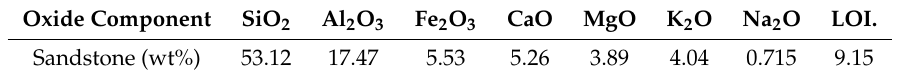
Figure 1. XRD pattern of sandstone. Table 1. Chemical composition of sandstone.